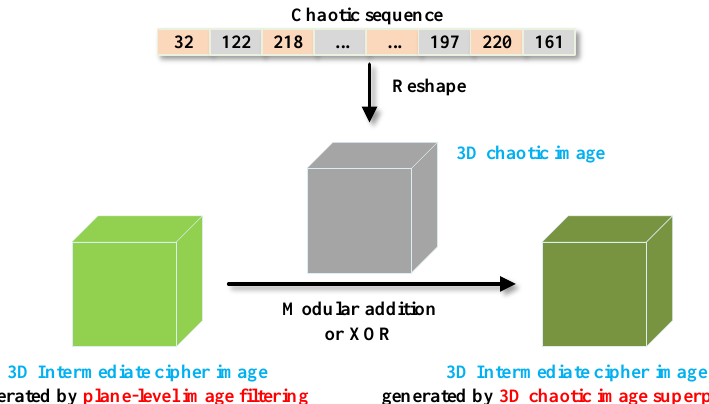
Figure 6. Chaotic image superposition of